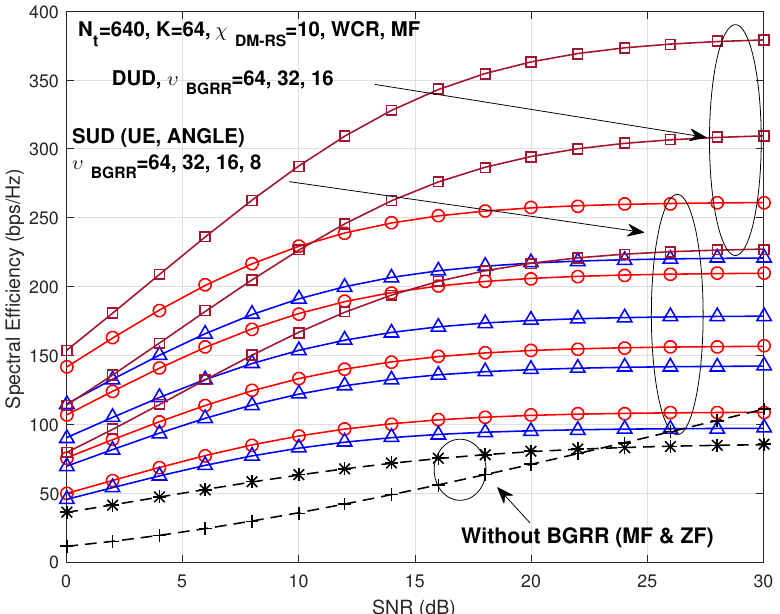
Figure 12. SE (bps/Hz) versus SNR (dB), when N t = 640, K = 64, χ DM − RS = 10, υ BGRR = 64,32,16,8, MF group precoding. Red solid lines with ’ O ’ marks are the UE based grouping and blue solid ’ (cid:52) ’ marks are the angle based